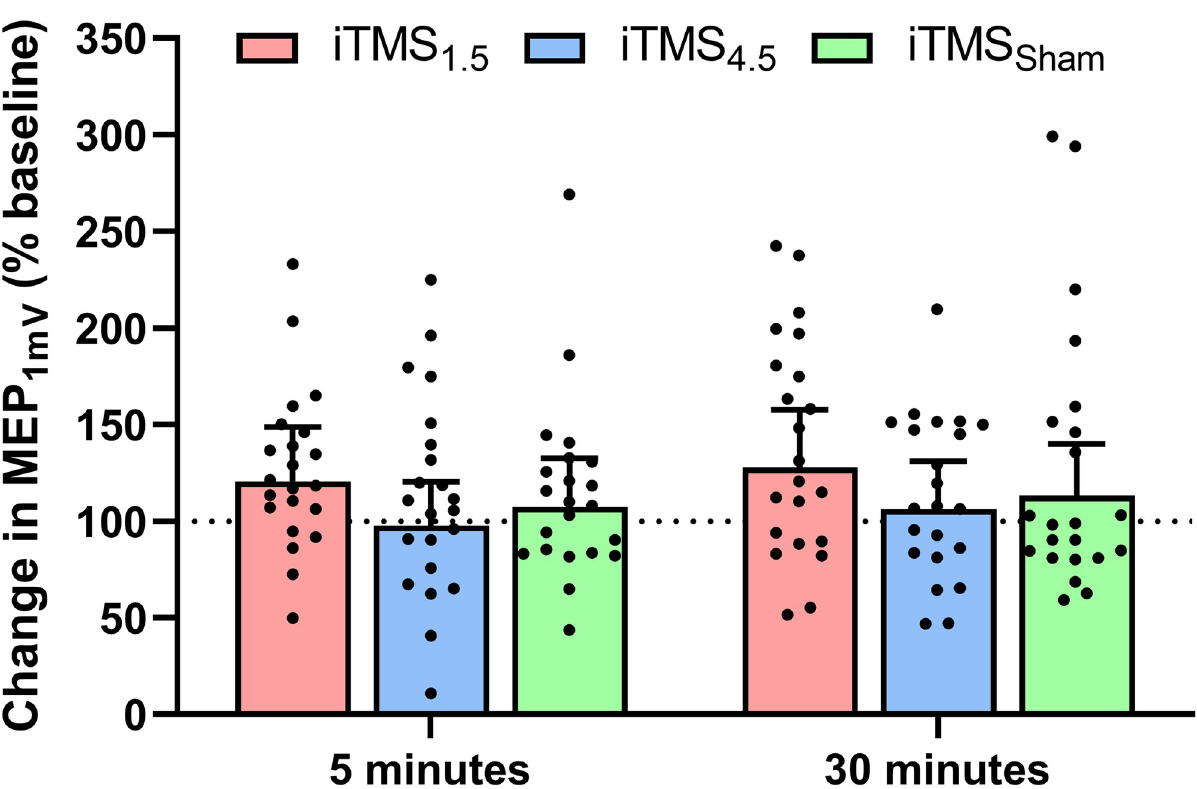
Fig 3. Changes in corticospinal excitability following iTMS